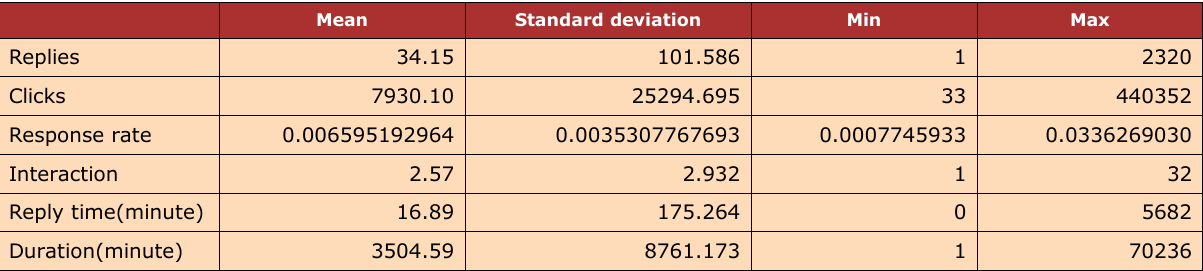
Table 4. Descriptive statistics of cognitive attention